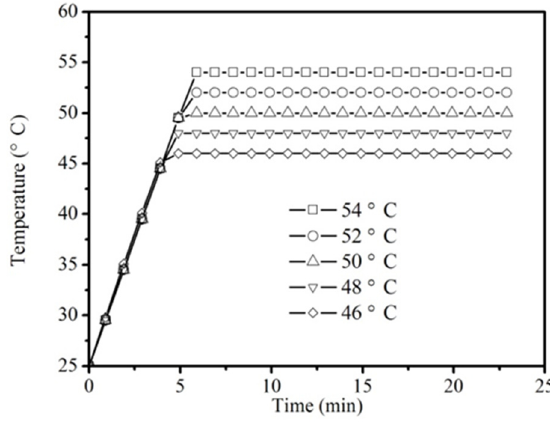
Figure 5. Temperature–time histories for the thermal treatment.